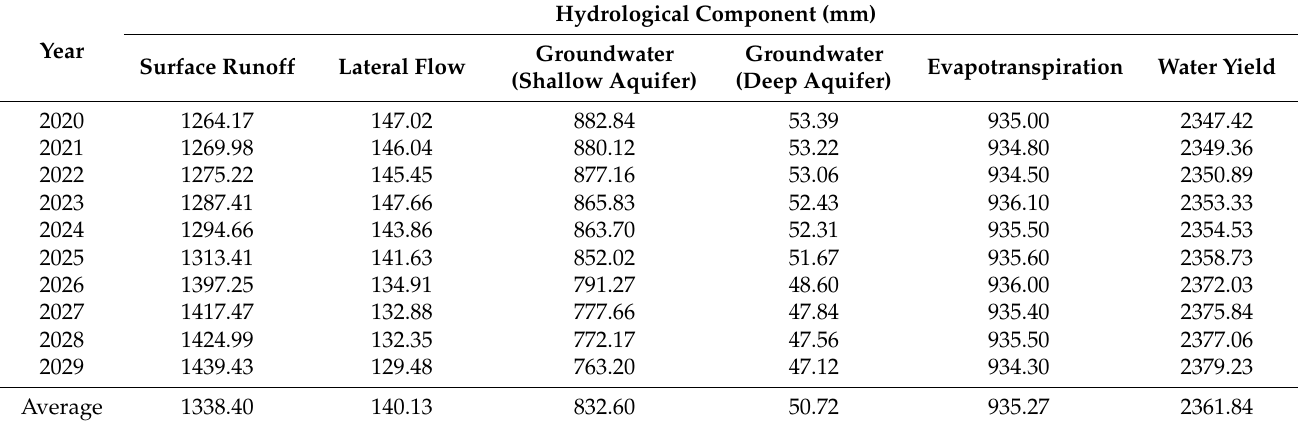
Table 18. Annual water yield of Phuket Island between 2020 and 2029 under the wet year scenario.